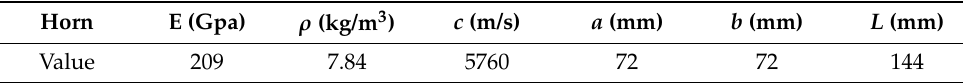
Table 2. Parameters of the ultrasonic